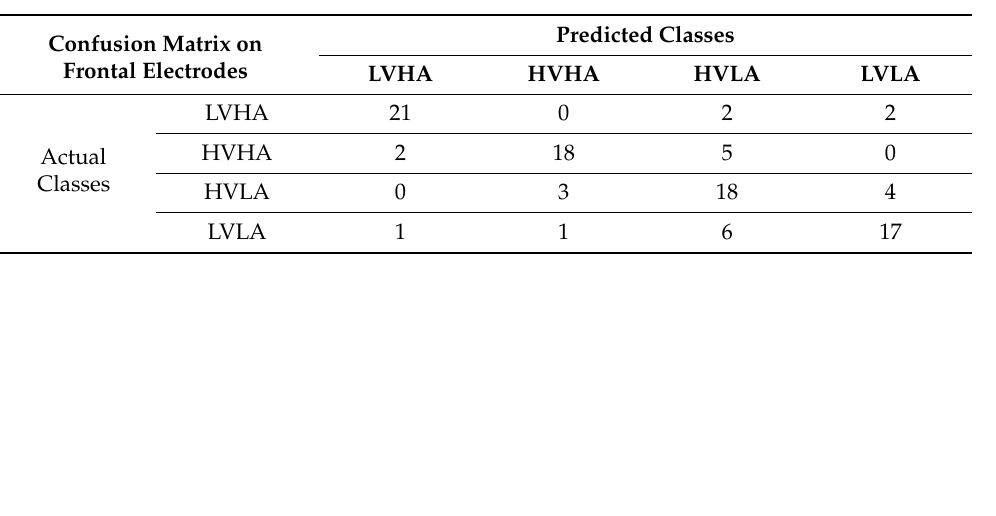
Table 10. The confusion matrix with differential average